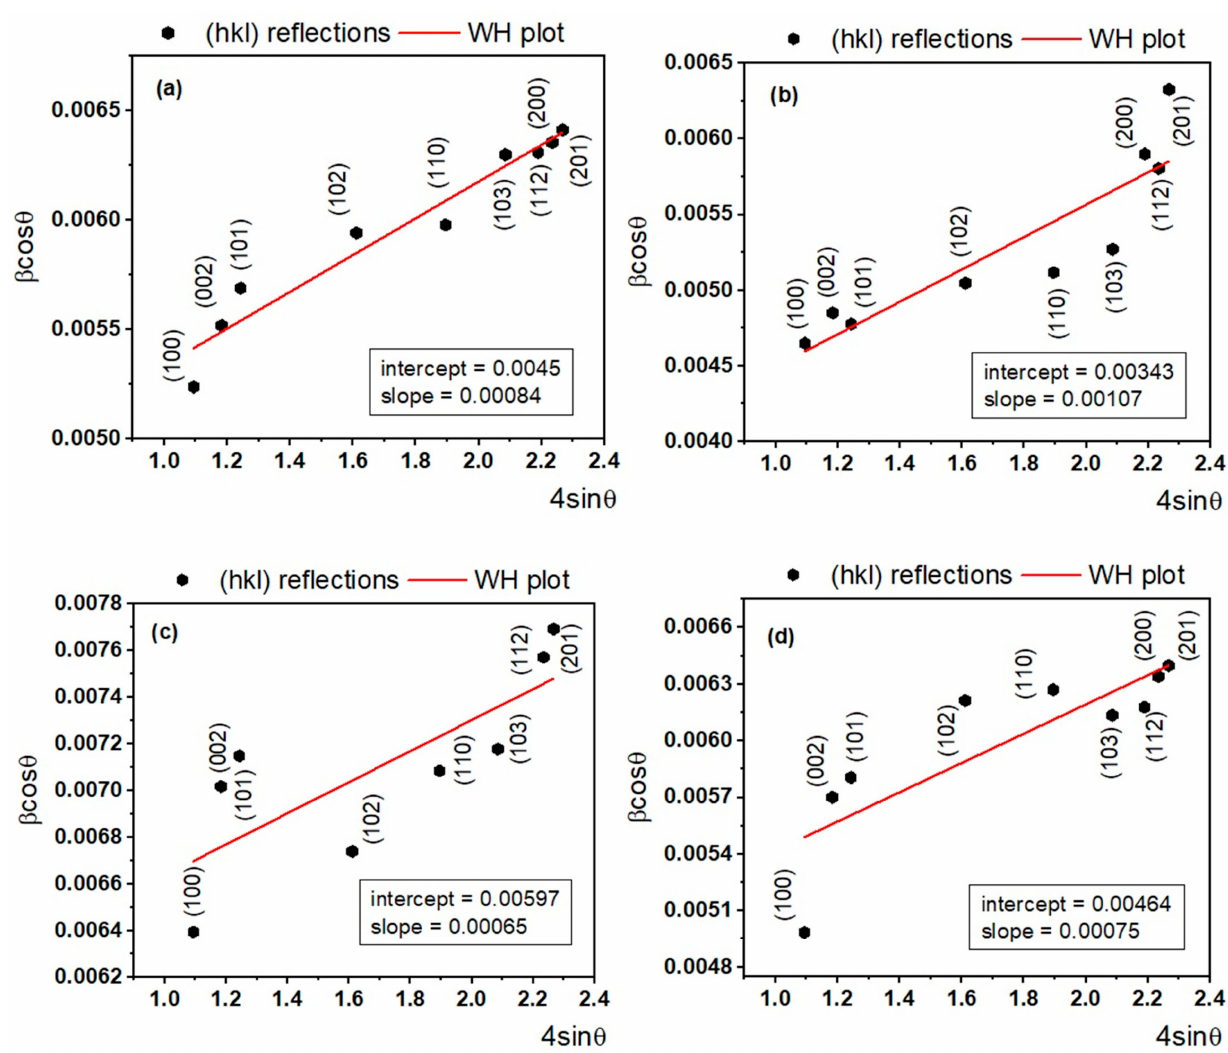
Figure 2. Williamson–Hall plot (red line) on different (hkl) reflections for Nd-doped ZnO samples: ( a ) ZnO:Nd (0.05%), ( b ) ZnO:Nd (0.1%), ( c ) ZnO:Nd (0.5%), and ( d ) ZnO:Nd (1%), respectively. Based on the linear plots, the following values for the mean crystallite size and lattice strain were obtained: 31.8 nm (0.05% Nd), 42.1 nm (0.1% Nd), 24.2 nm (0.5% Nd), and 30.8 nm (1% Nd) (mean crystallite size), and 0.084% (0.05% Nd), 0.107% (0.1% Nd), 0.065% (0.5% Nd), and 0.075% (1% Nd) (lattice strain). For the undoped ZnO sample, the value 36.9 nm was obtained.